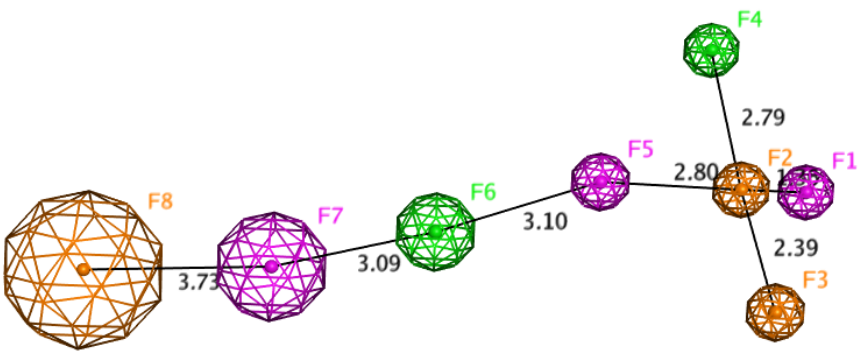
Figure 7. Pharmacophore model for the novel class of acetylcholinesterase inhibitors (meaning of colors: orange – aromatic feature, green – hydrophobic, pink – H-bond donor; radius of feature represents precision of